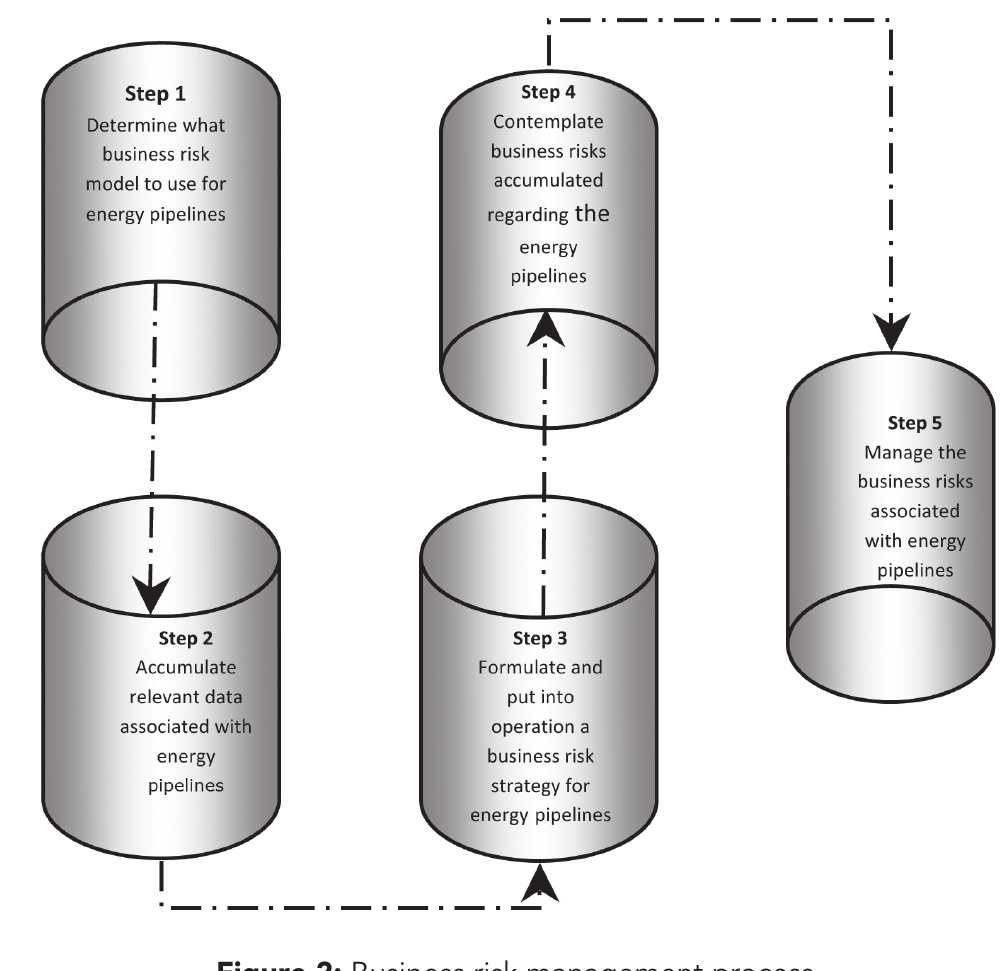
Figure 2: Business risk management process Source: Developed by